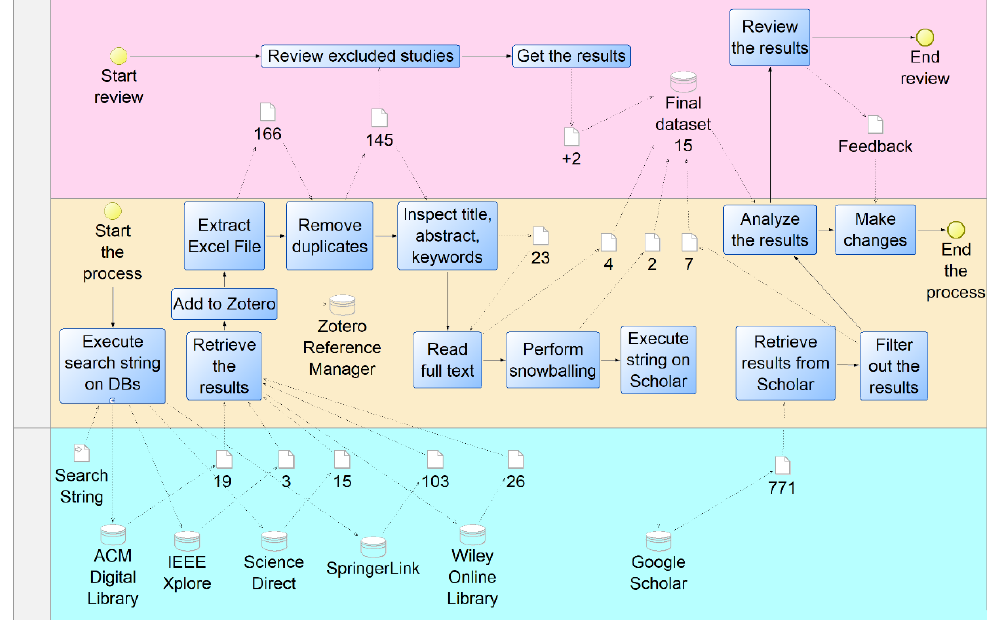
Figure 1. Overview of our Research Process.